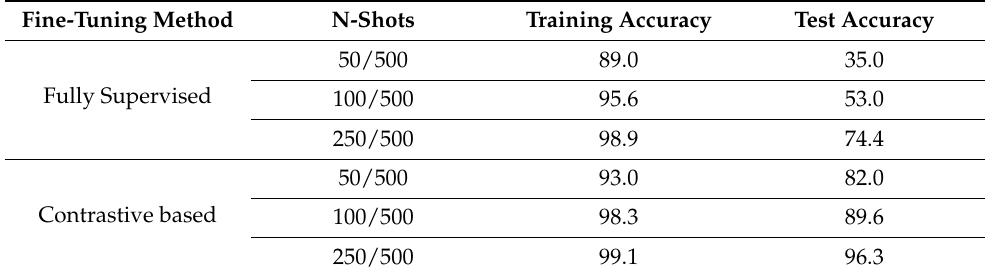
Table 2. Accuracy comparison of contrastive learning and fully supervised methods for few-shot fine-tuning for new